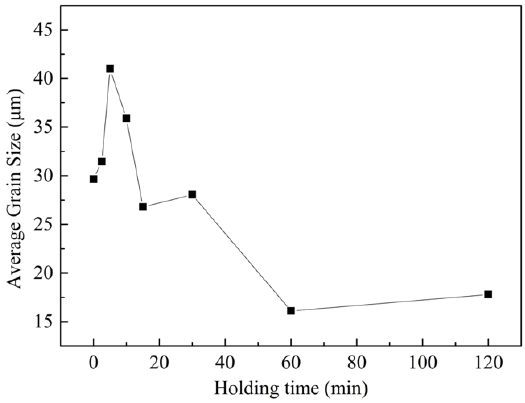
Figure 8. Effect of an isothermal heat treatment on the average grain size in Mg–10Zn–6.8Gd–4Y. Figure 8. E ff ect of an isothermal heat treatment on the average grain size in